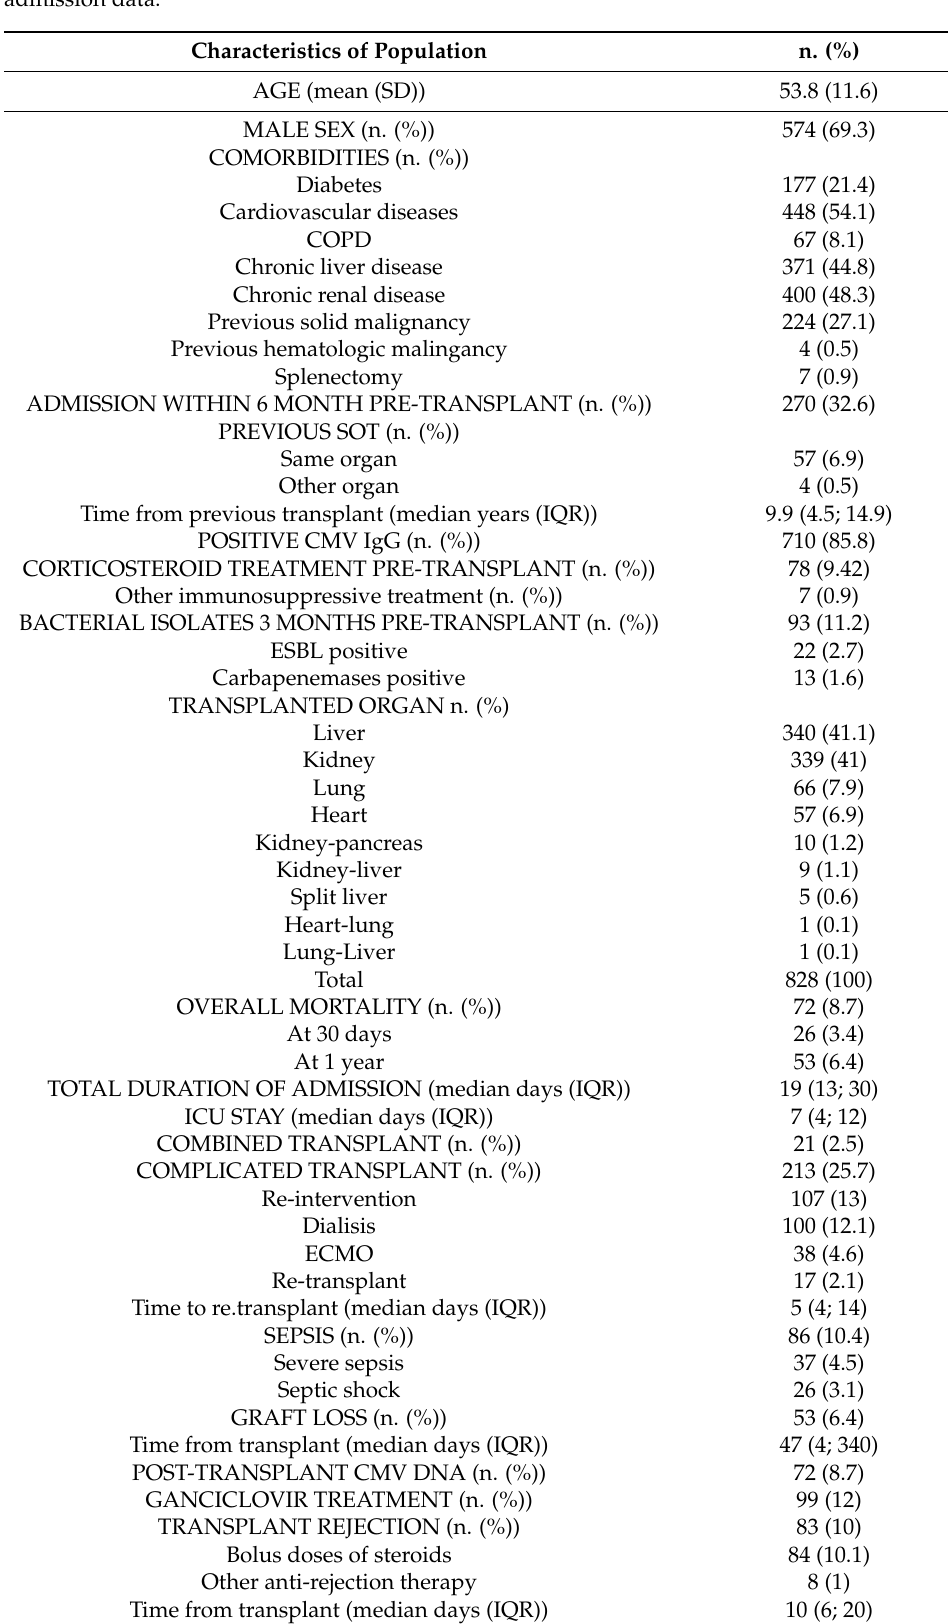
Table 1. Demographics, pre-transplant co-morbidities, transplant distribution, and post-transplant admission